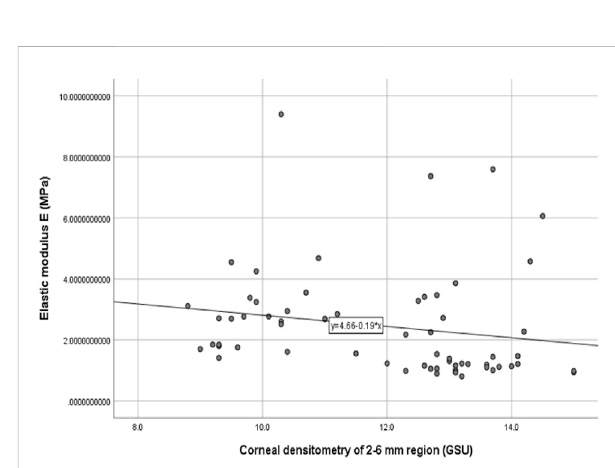
FIGURE 2 Correlation between the corneal densitometry of 2 – 6 mm region and Elastic modulus E (R = − 0.39, p =